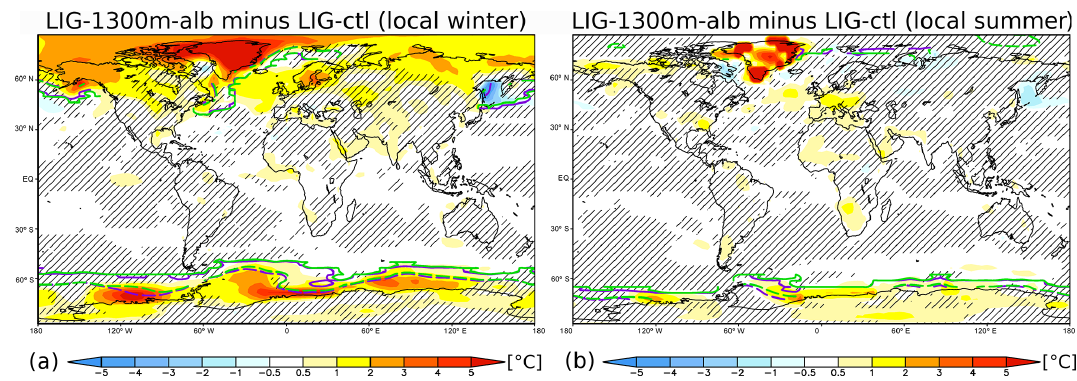
Figure 3. Effect of Greenland Ice Sheet elevation and albedo on surface temperature in the 130kyrBP simulation (LIG-1300m-alb). Same as Fig. 2c but for (a) local winter mean (coldest month) and (b) local summer mean (warmest month). Violet dashed lines represent the LIG-1300m-alb 50% compactness sea ice isoline, while violet continuous lines represent the LIG-1300m-alb sea ice edge. Green dashed lines represent the LIG-ctl 50% compactness sea ice isoline, while green continuous lines represent the LIG-ctl sea ice